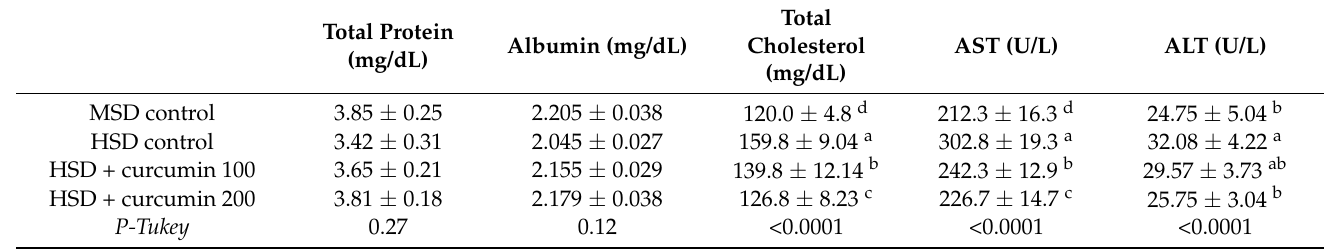
Table 7. Effect of curcumin on biochemical parameters in the serum of broilers reared under high stocking density.